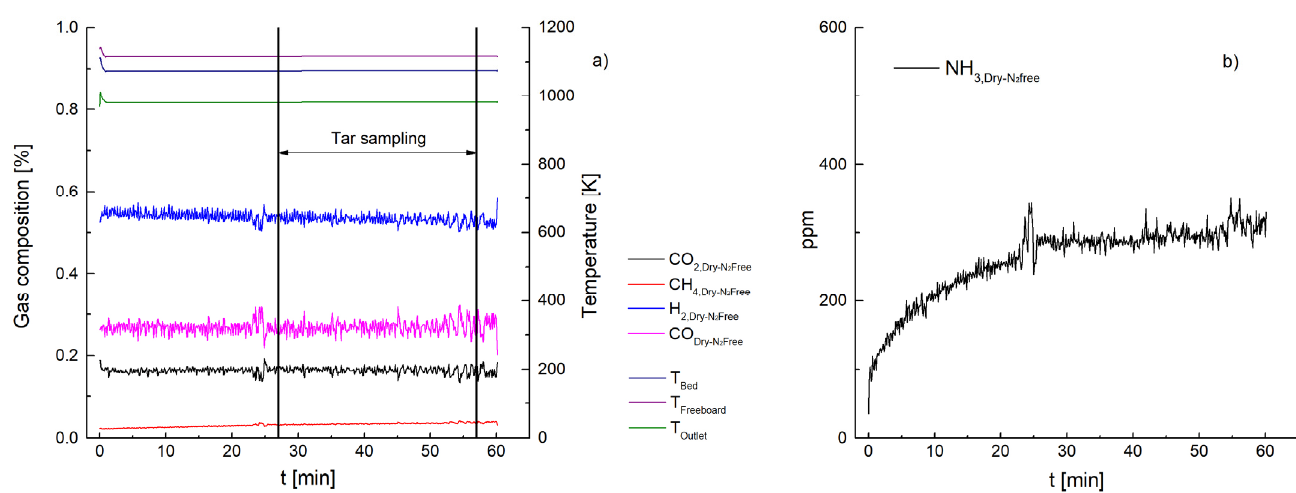
Figure A2. Temperature and gas composition ( a ) and ammonia content ( b ) during test 2.